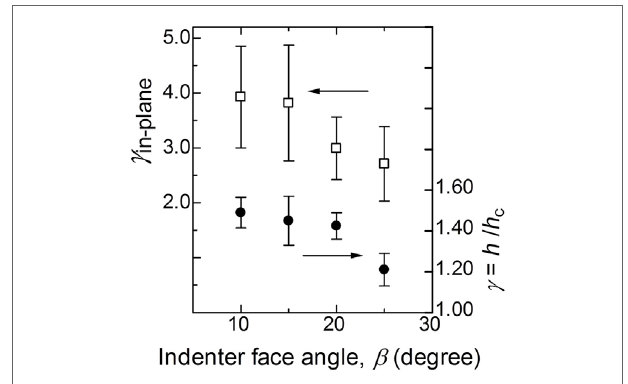
FigUre 8 | relationships between sinking-in parameters, γ or γ in-plane, and the face angle of indenter . Error bars denote ± 1